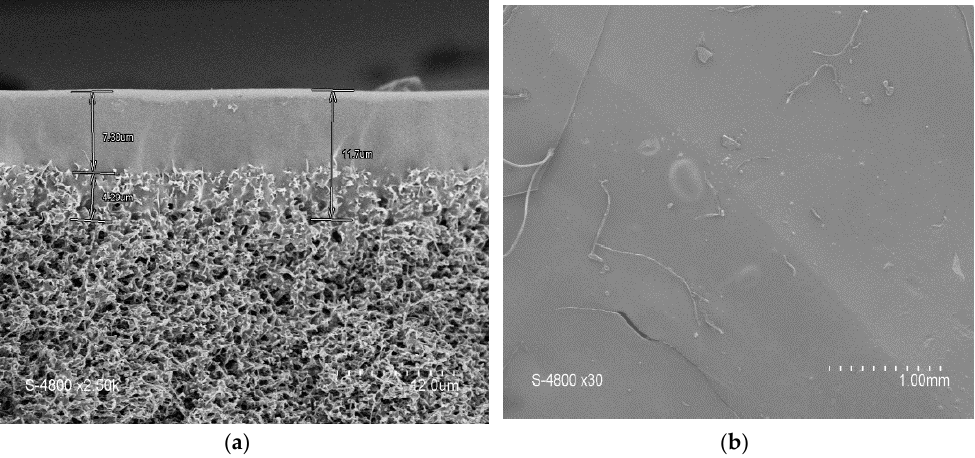
Figure 3. ( a ): SEM images of a membrane obtained from a micellar solution of 20 wt % of PMMA-b-PSBMA block copolymer solution in TFE:water mixture (87:13% in volume) casted on the surface of a commercial hydrophobic PVDF membrane using a 250 µm casting knife. ( a ) Cross section. ( b ) Top surface.